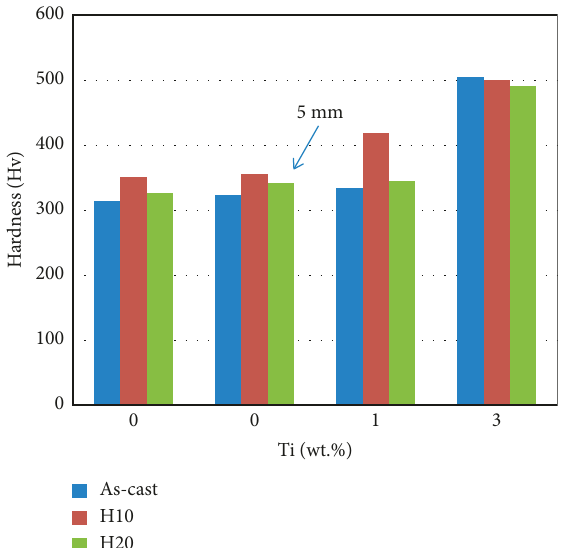
Figure 11: The hardness values of the different